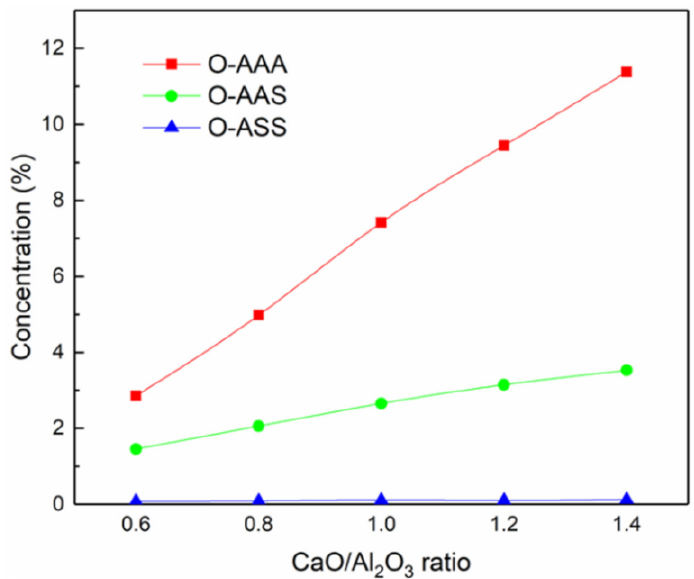
Figure 6. Evolution of different tricluster oxygen (TO) with various CaO/Al 2 O 3 ratios.